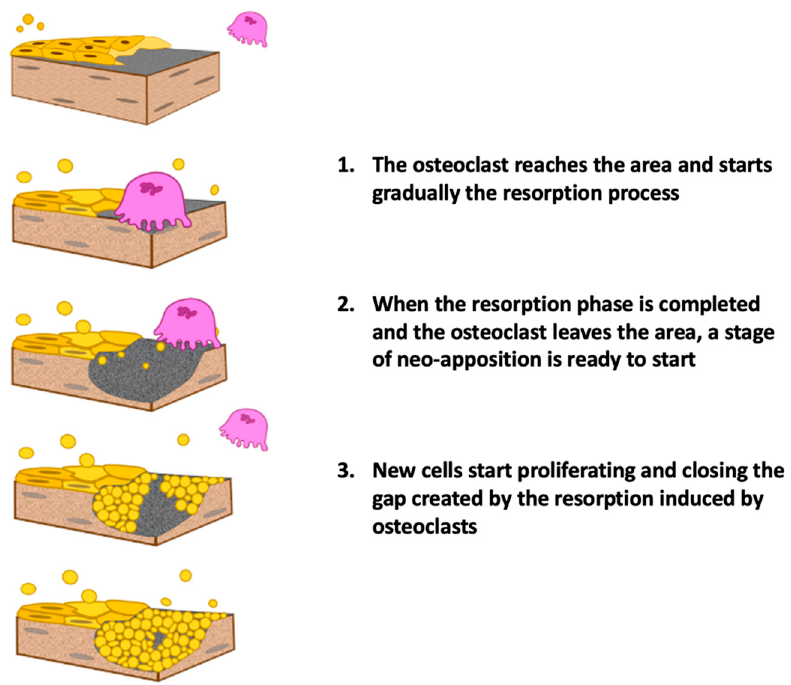
Figure 1. Role of the bone remodeling unit (BMU) in bone remodeling process.